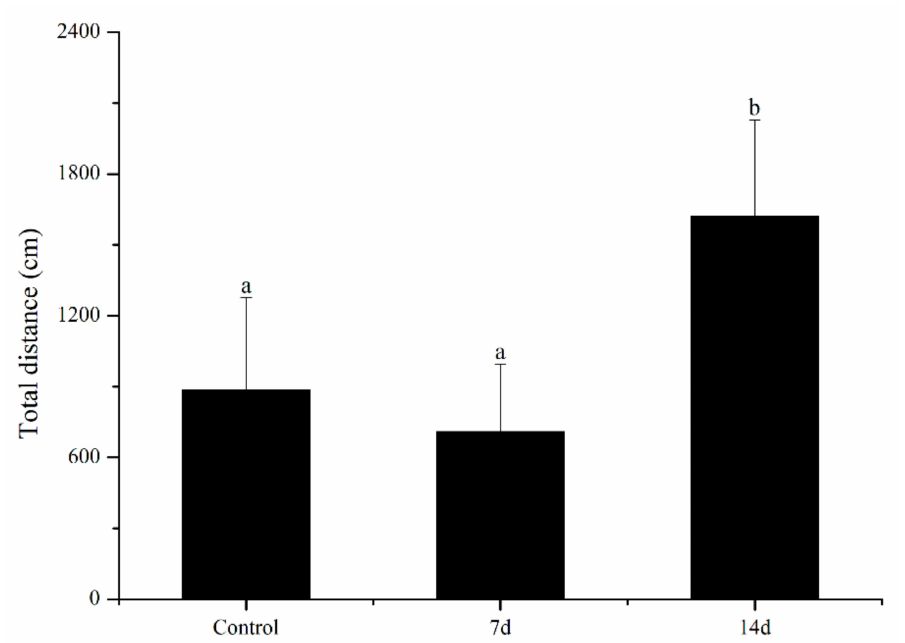
Figure 5. Effects of 7 and 14 days of the UCS protocol on the total distance in the rare minnow. Data are expressed as mean ± SE (n = 18). The different letters in the bar indicate significant differences between the two groups ( p < 0.05).